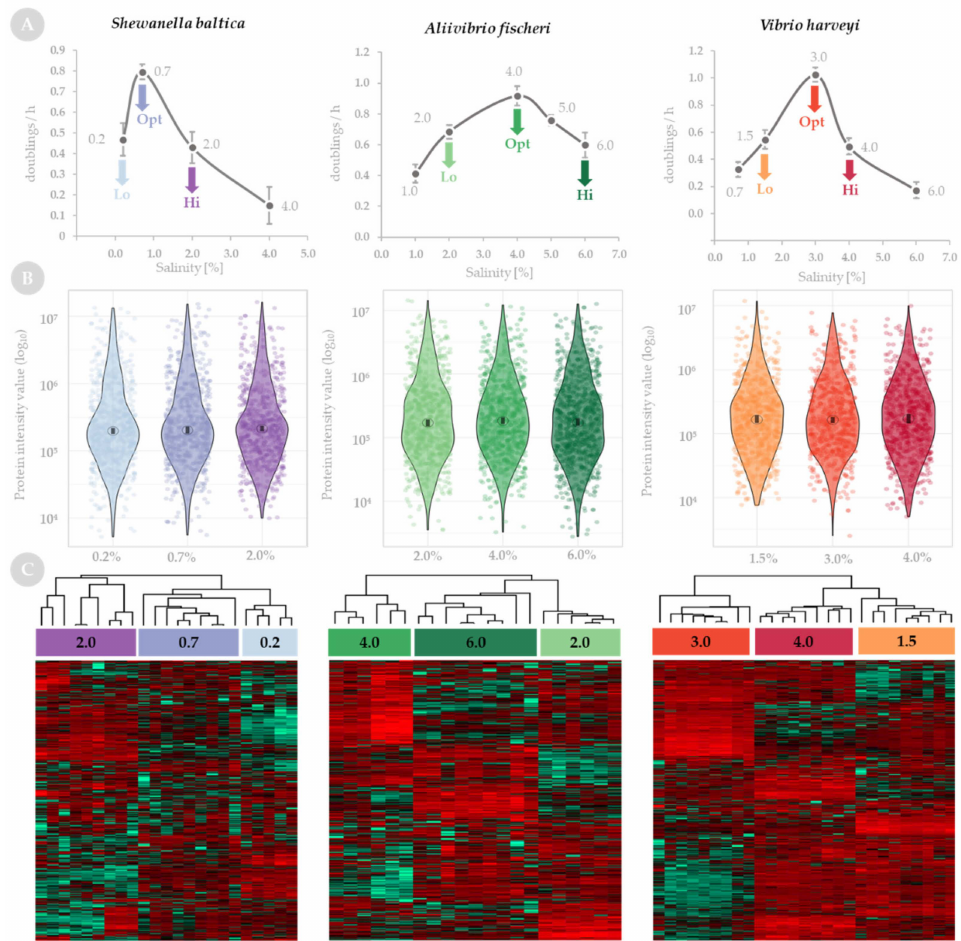
Figure 1. Bacterial growth and quality of protein samples identified by liquid chromatography with tandem mass spectrometry (LC-MS/MS) in S. baltica , A. fischeri and V. harveyi in response to salinity stress. ( A ) Growth rates determined for bacterial species cultured at different salt concentrations and presented as doublings per hour. Numbers on the plot correspond to salt concentrations at which these were assessed. Lo—low salinity, Hi—high salinity, Opt—optimal salinity. ( B ) Violin plots present the distribution of the abundance of all proteins detected by LC-MS/MS at low, optimal and high salinity. The percentage of salinity is presented on the x-axis. Obtained protein intensity values, normalized by a total area sums (TAS) approach are plotted on a log 10 scale on the y-axis. Graphs show the data for each protein as jittered dots; an open circle indicates the median of the data and a vertical bar indicates for each median the 95% confidence interval determined by bootstrapping. ( C ) Heatmaps present protein expression at low, optimal and high salinity (percentage of salinity is marked above heatmaps); data are presented as z-score transformed, scaled in rows, values. Both biological and technical replicates are shown, and hierarchical clustering of replicates is presented above each